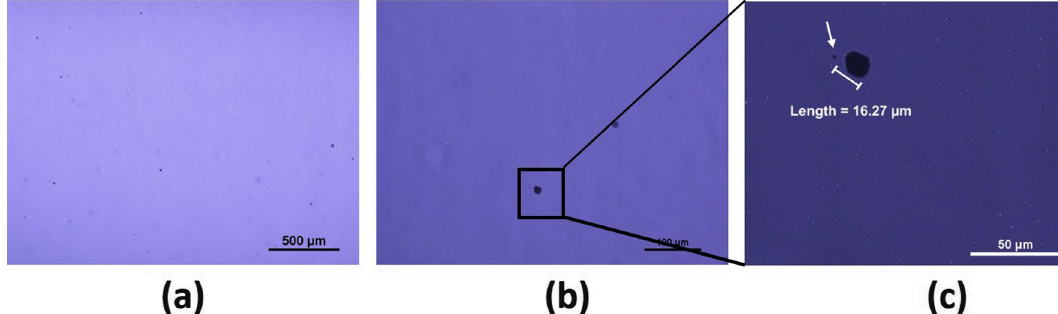
Figure 4. High magnification IR transmission images with higher magnifications from left to right. Length of the Te-inclusion indicated in ( c ) is 16.27 µm. The scale bars indicated on bottom right corners correspond to 500 µm, 100 µm and 50 µm for figure ( a – c )